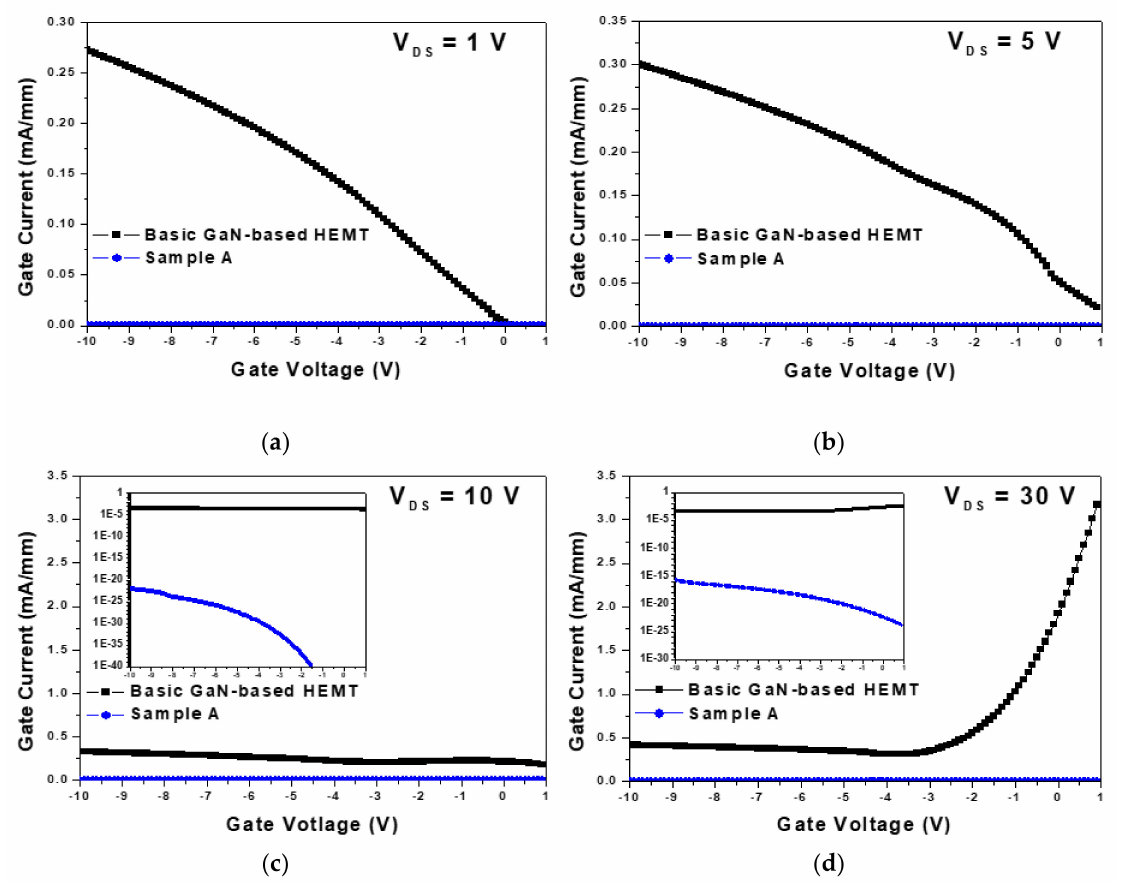
Figure 6. Gate leakage current for BG-HEMT and MIS-HEMT (sample A) with respect to V GS at ( a )